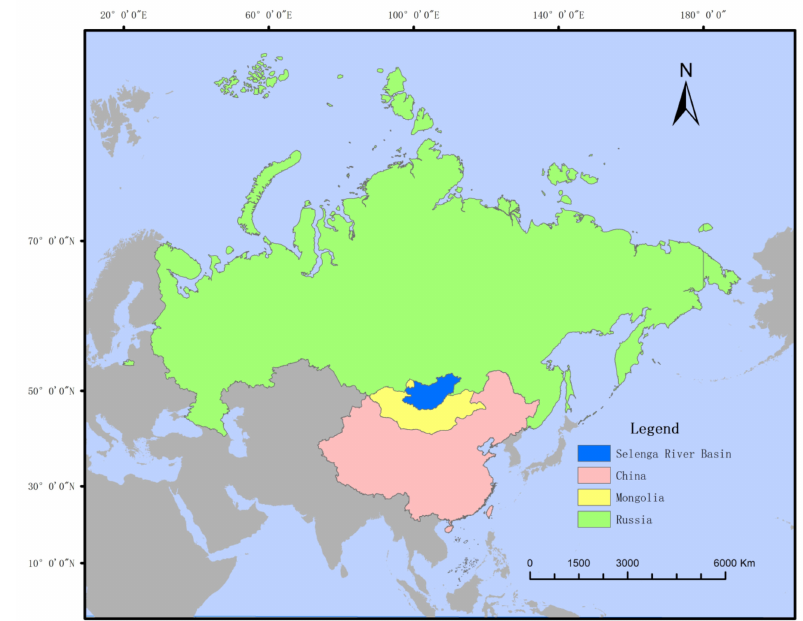
Figure 1. The location of the Selenga River